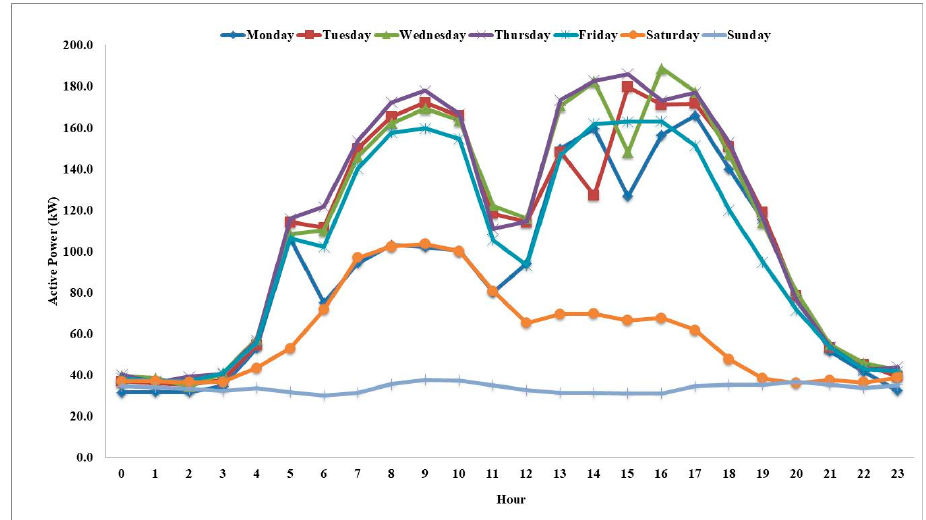
Figure 10. Active Power Consumption.